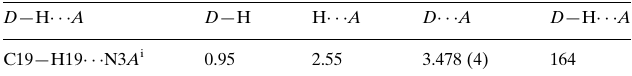
Hydrogen-bond geometry (A˚ , (cid:3)